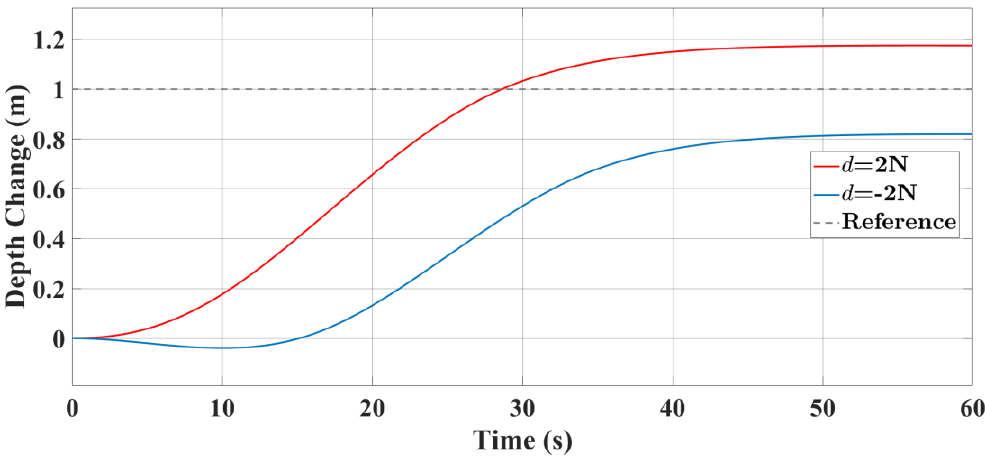
Figure 22. Hovering control responses under external disturbances.